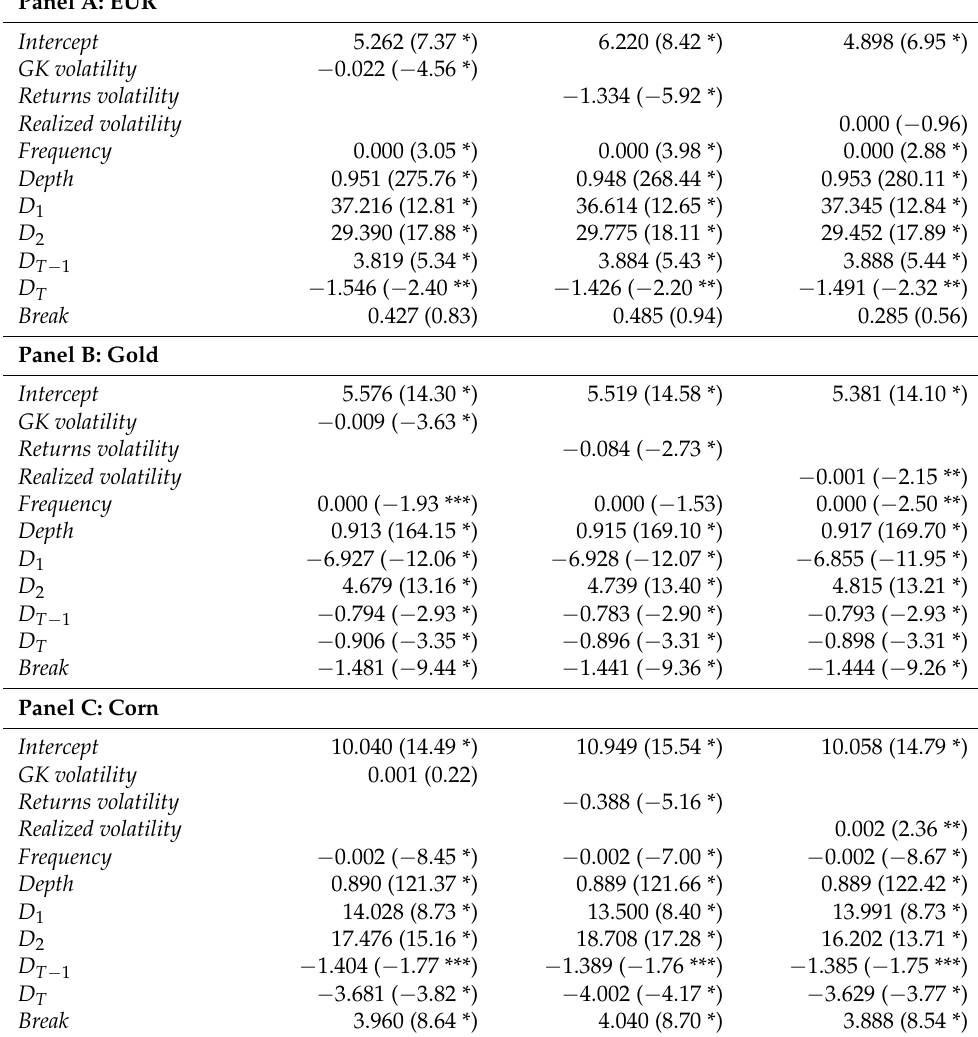
Table 7. Depth frequency and structural breaks. This table presents the coefficient estimates for the